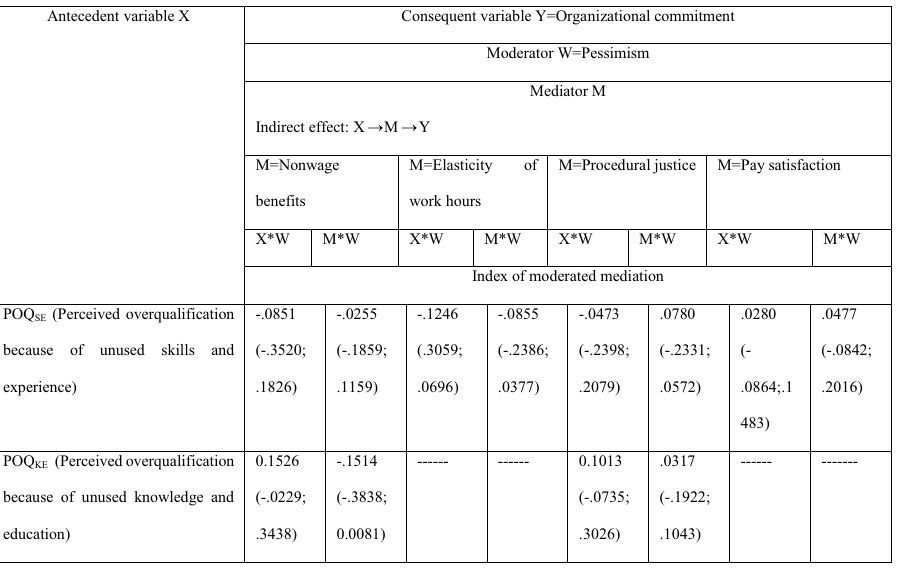
, and because of SE